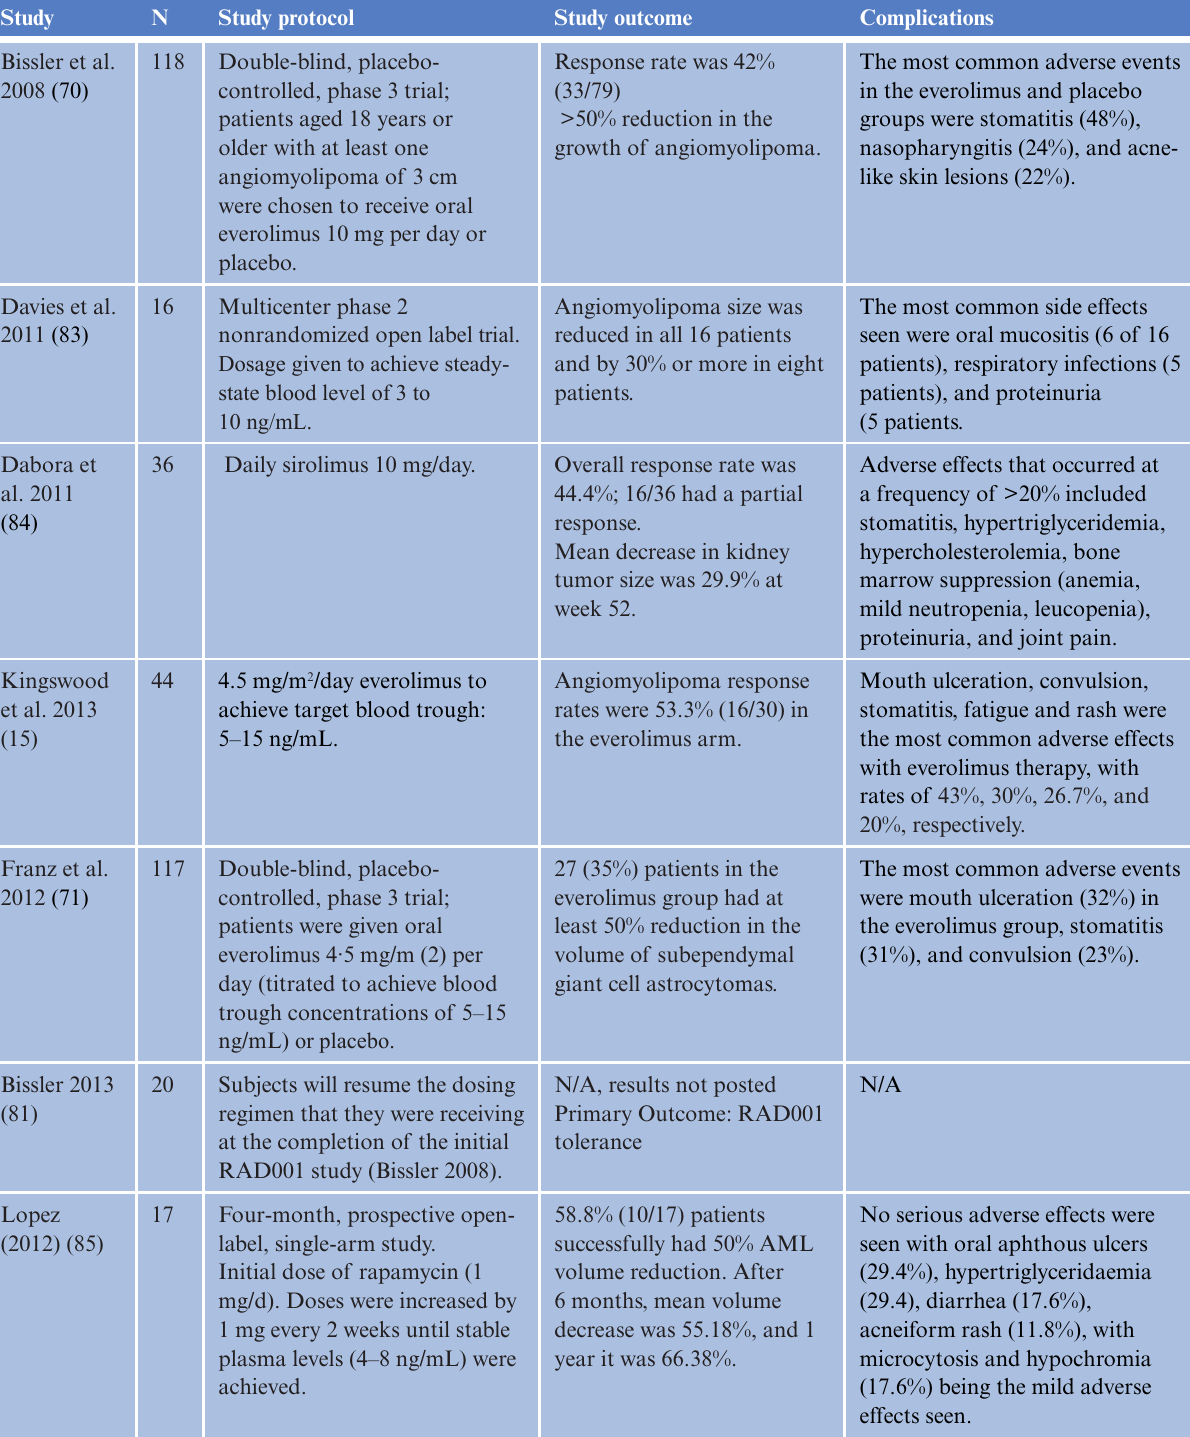
Table 6: List of mTOR inhibitors